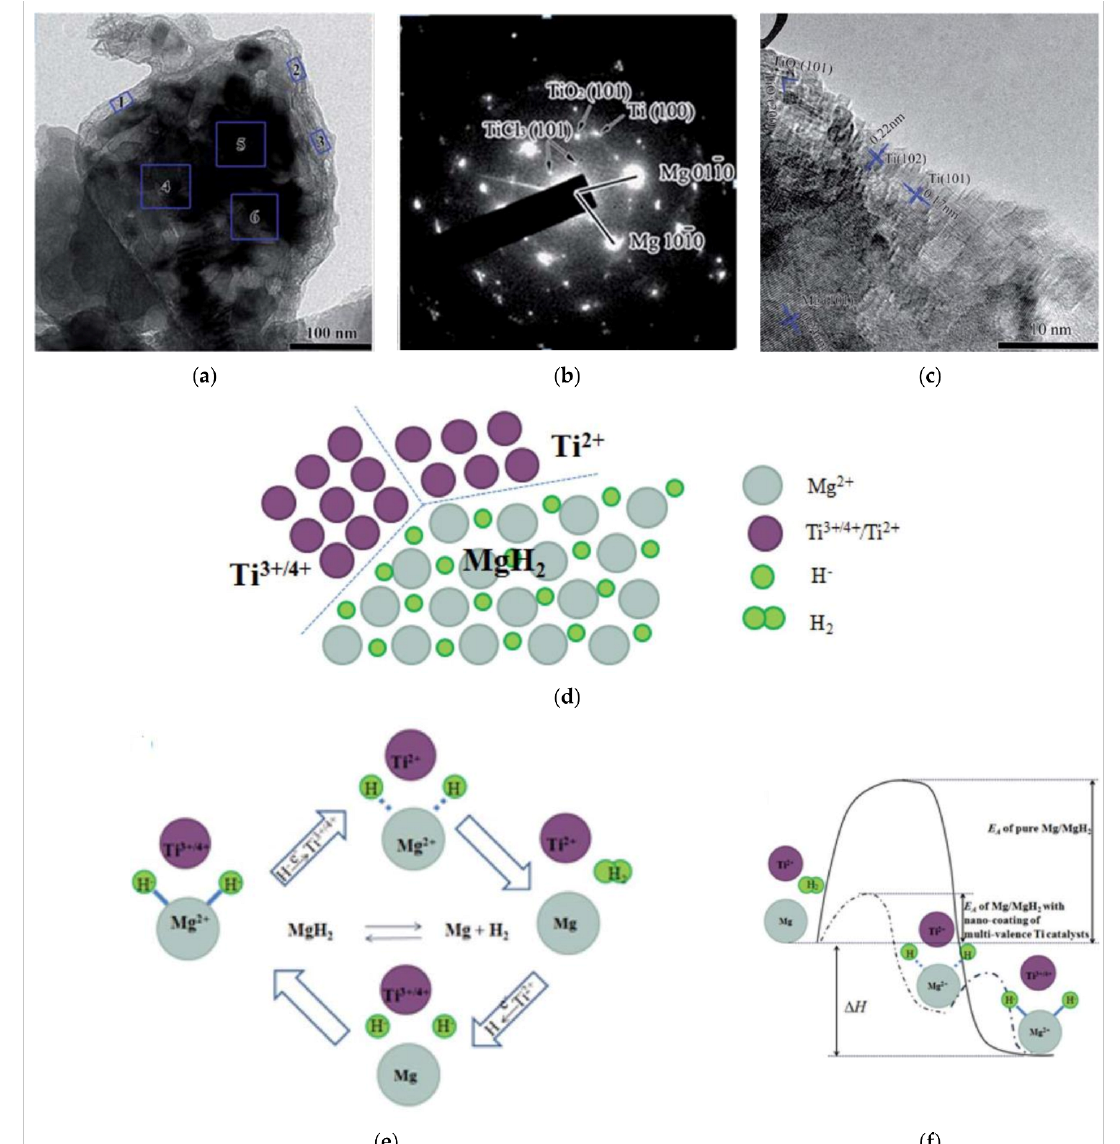
Figure 36. TEM micrographs of the samples as prepared by the chemical reaction between Mg powders and TiCl 3 in THF solution. ( a ) Bright field, ( b ) electron diffraction pattern, ( c ) HR-TEM images. ( d – f ) The schematic diagram of the catalytic mechanism in de/hydrogenation of the samples. ( a – f ) Reproduced with permission [270]. Copyright 2013, Royal Society of